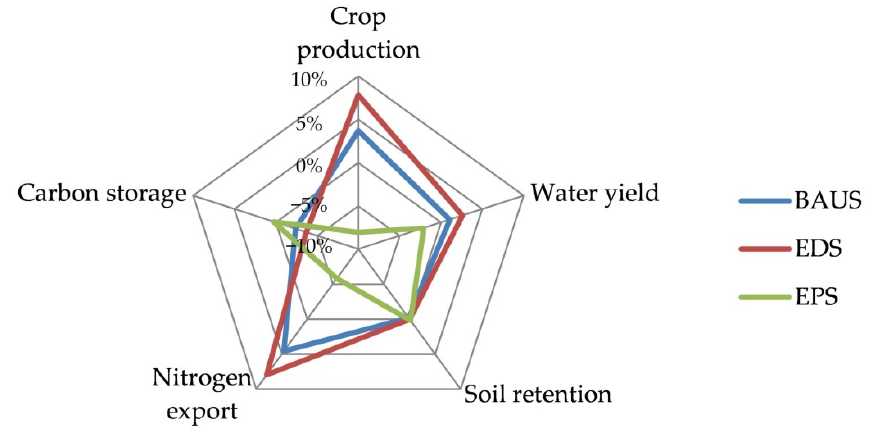
Figure 8. Percentage difference of the ecosystem services under the alternative scenarios.